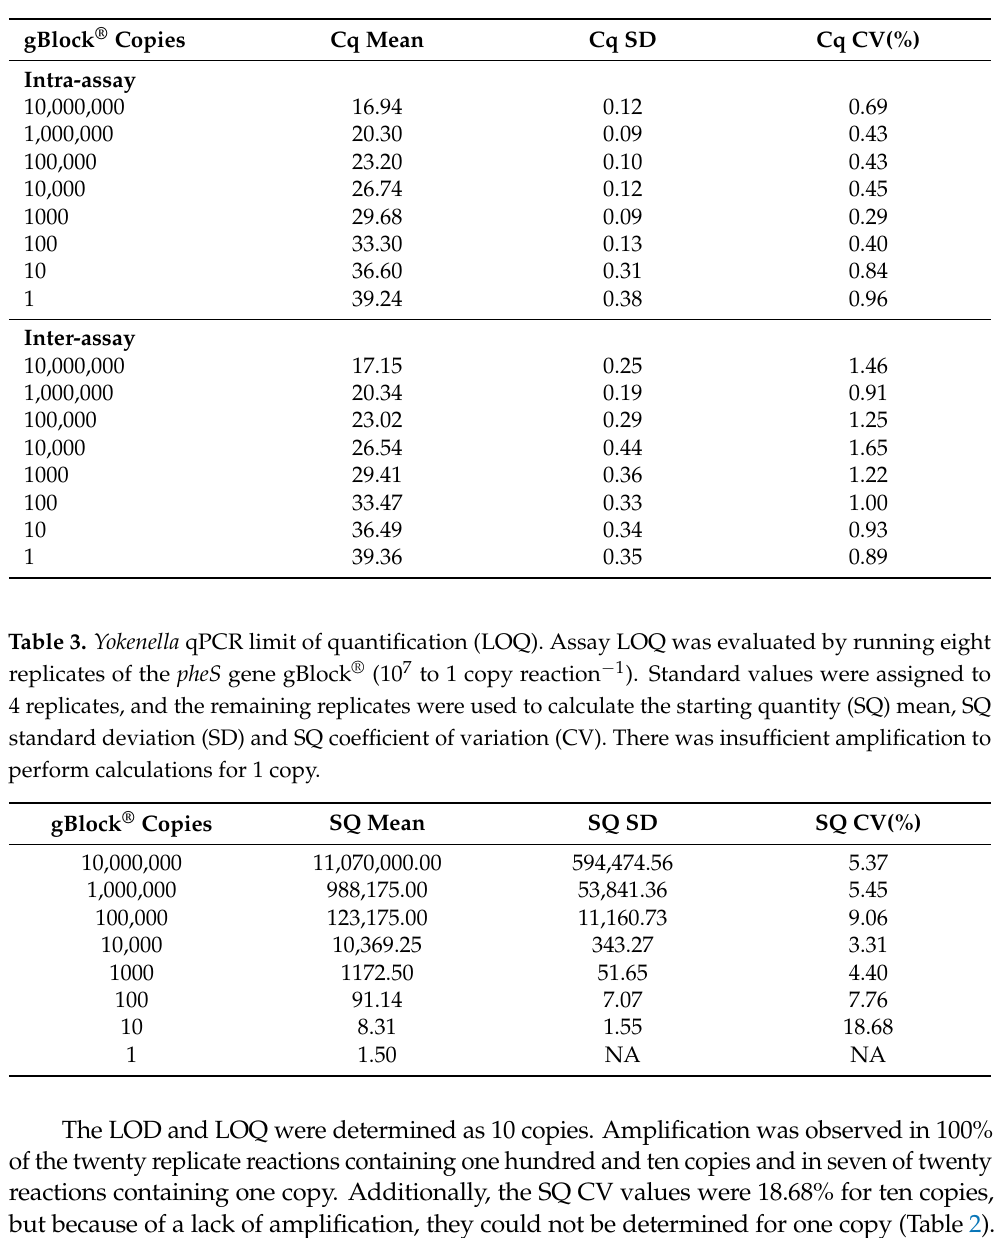
(<2%) for both intra- and inter-assay variation (Table 2). Across triplicate plates, linear regression of Cq values versus log 10 gBlock ® demonstrated an average R 2 value of 0.997